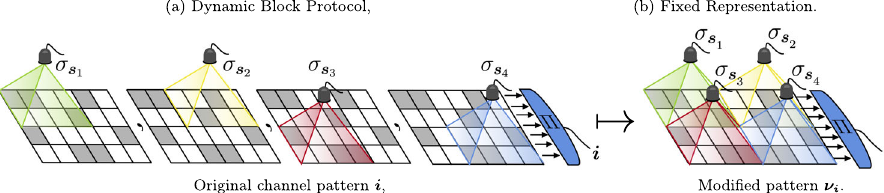
Fig. 2 Dynamic to fi xed block protocol transformation. a Non-disjoint probe-domain distributions can be decomposed into multiple rounds of disjoint pattern interaction, generating a dynamic discrimination protocol. This dynamic protocol can be equivalently represented by a fi xed block protocol on a modi fi ed image space, as shown in b . The original (6 × 4)-channel pattern i is transformed into a (8 × 4)-pattern ν which has been appropriately modi fi ed in accordance with the non-disjoint probe-domain distribution S nd using Eq. (13). Here we have assumed the use of single-copy probe states, M =